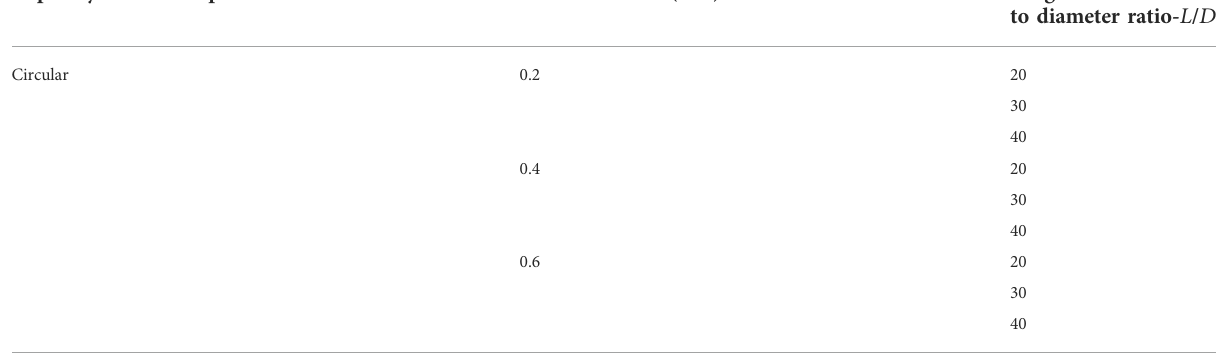
TABLE 4 The inner diameter and aspect ratio of the capillary used in the experiments. Capillary section shape